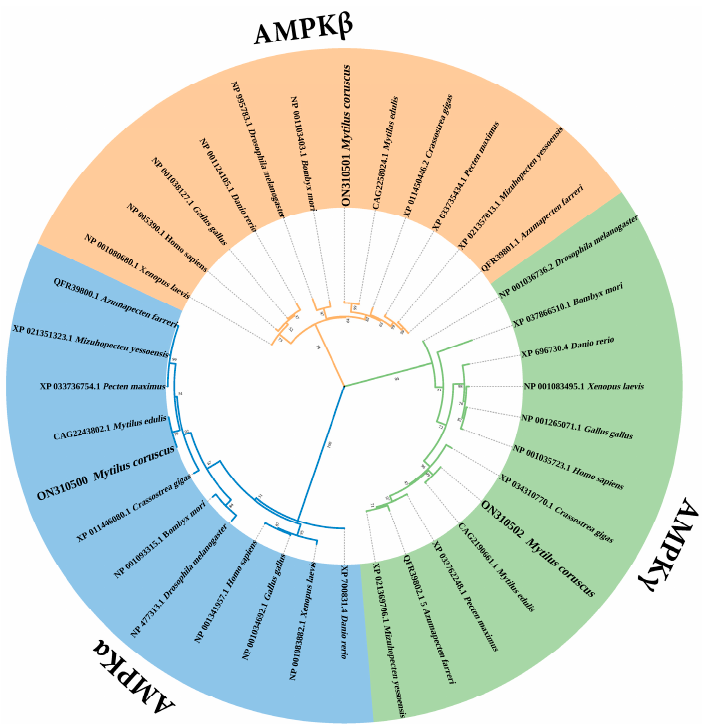
Figure 8. A phylogenetic analysis of McAMPKs. Numbers at the tree present the bootstrap values from 1000 replicates. 3.3. AMPK Inhibitor and Activators Regulate M. Coruscus Larval Metamorphosis